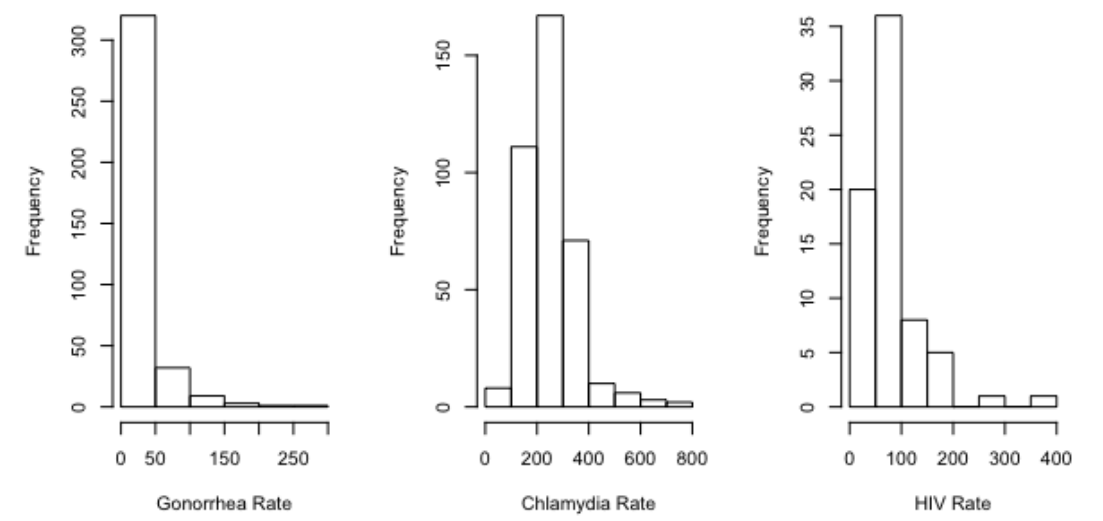
Figure A4. The distributions of rural county values of each of the response variables used in the model. A right skew is present for all STIs, with chlamydia presenting the least right skew.